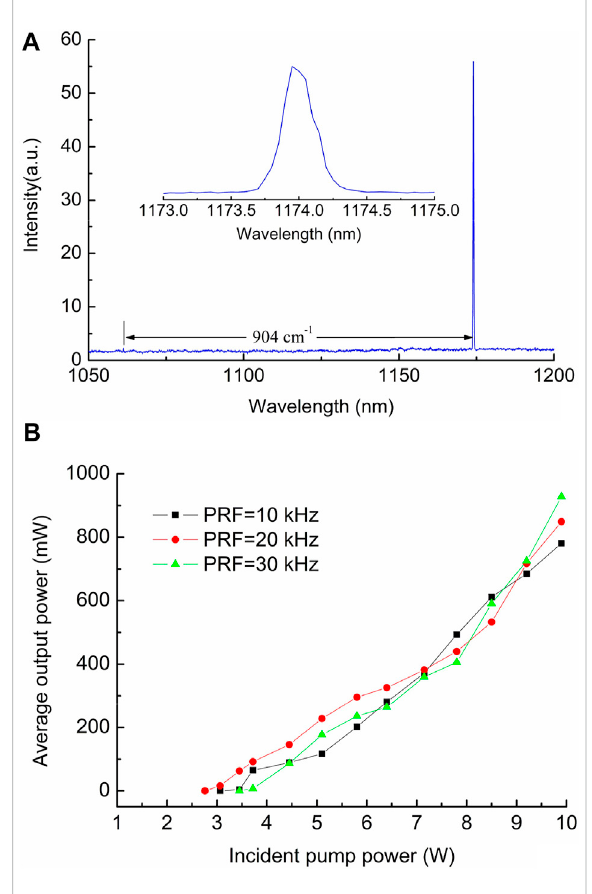
FIGURE 3 Laser spectra (A) and plot of the power transfer characteristics with different pulse repetition frequencies (B) of self-Raman laser